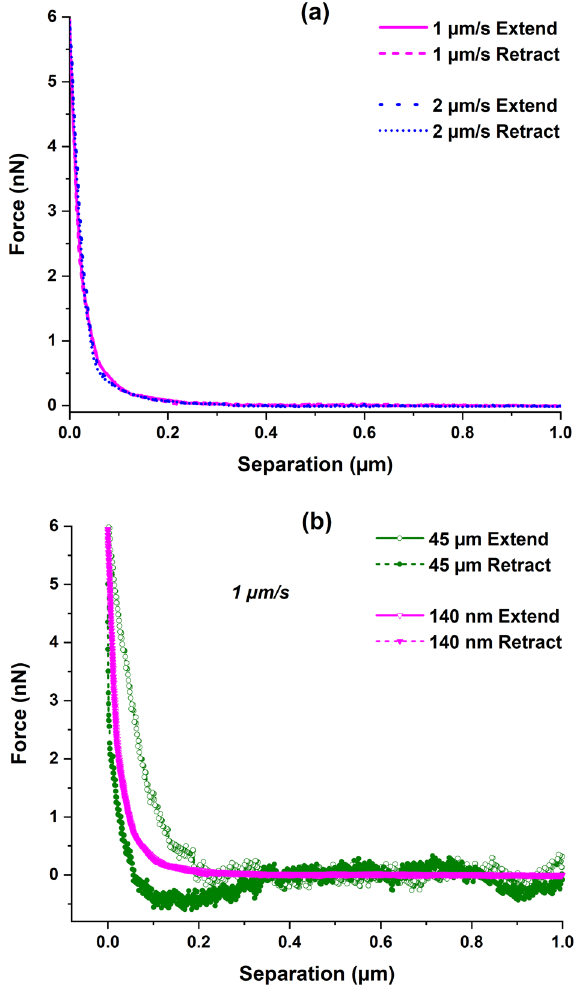
Figure 5. AFM indentation force-curves for lehfilcon A CL; ( a ) using the 140 nm diameter probe at two loading rates showing the absence of poroelastic effects during surface indentation; ( b ) using 45 µm and 140 nm diameter probes at 1 µm/s rate showing the presence of both viscous squeeze-out and poroelastic effects for the larger probe compared to the smaller